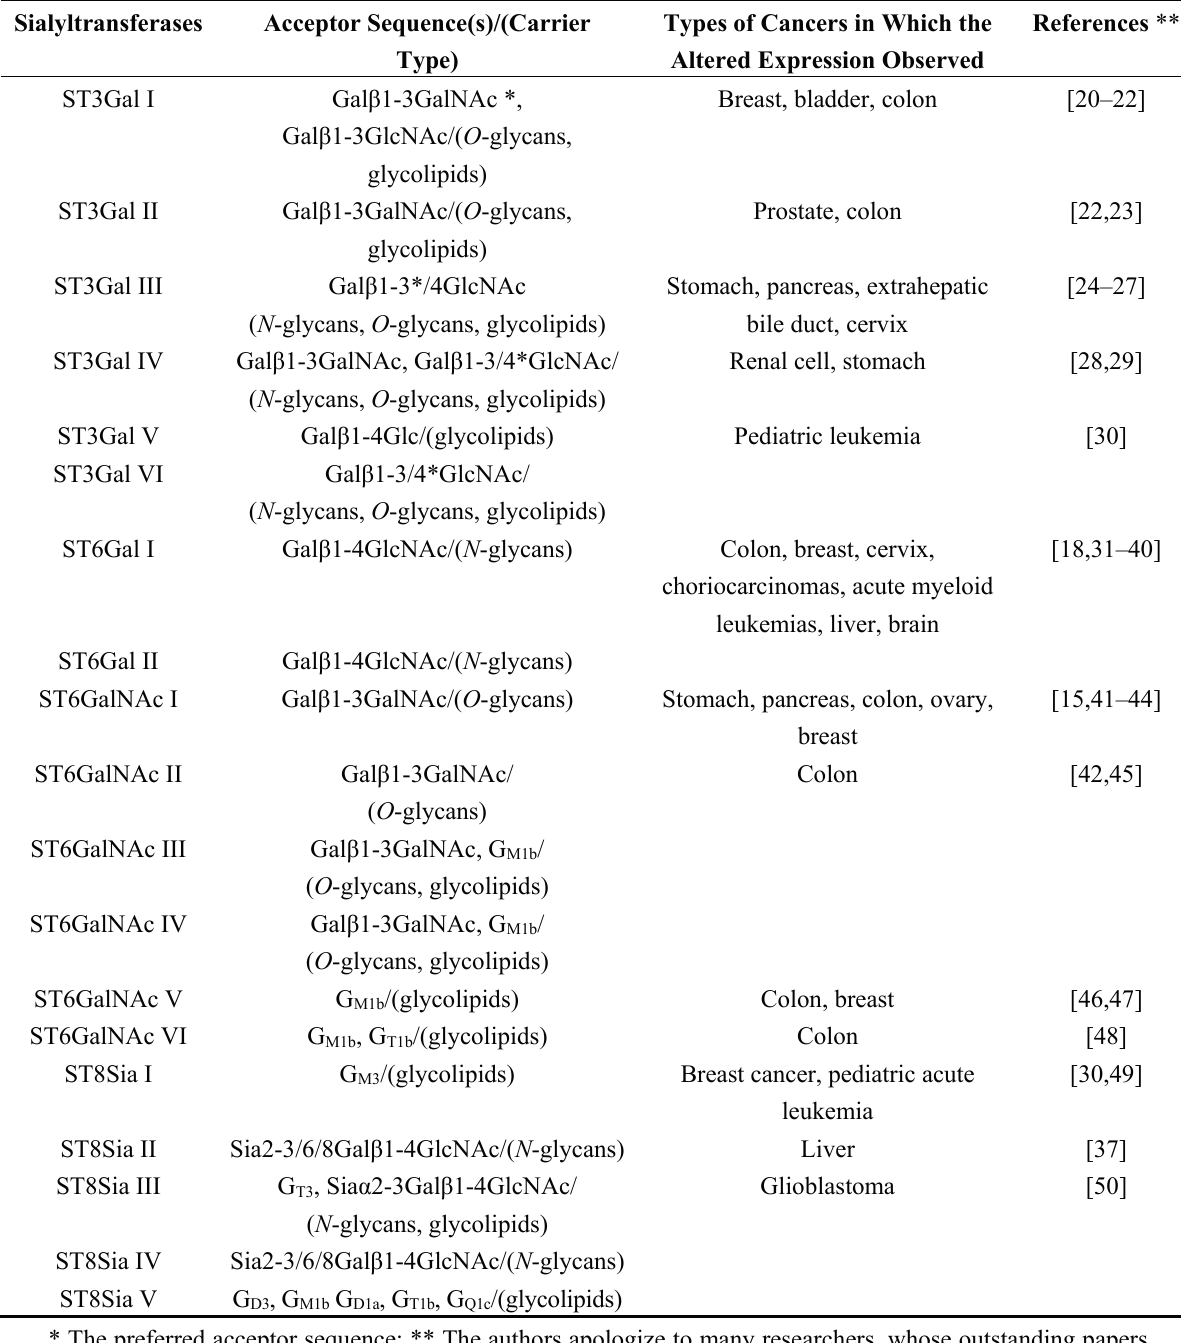
Table 1. Cloned sialyltransferases and their involvement in human cancers.